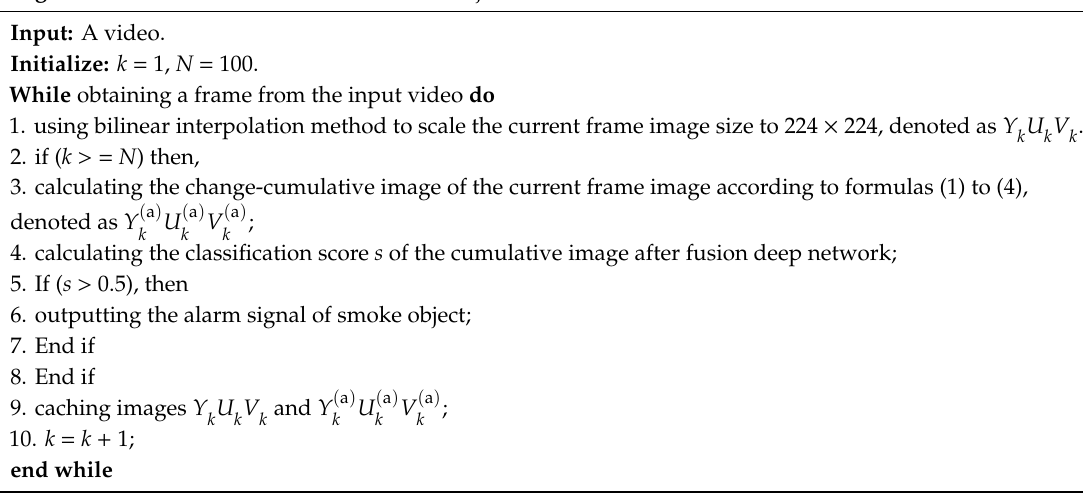
Algorithm 1. Procedure to detect the smoke object in a video.